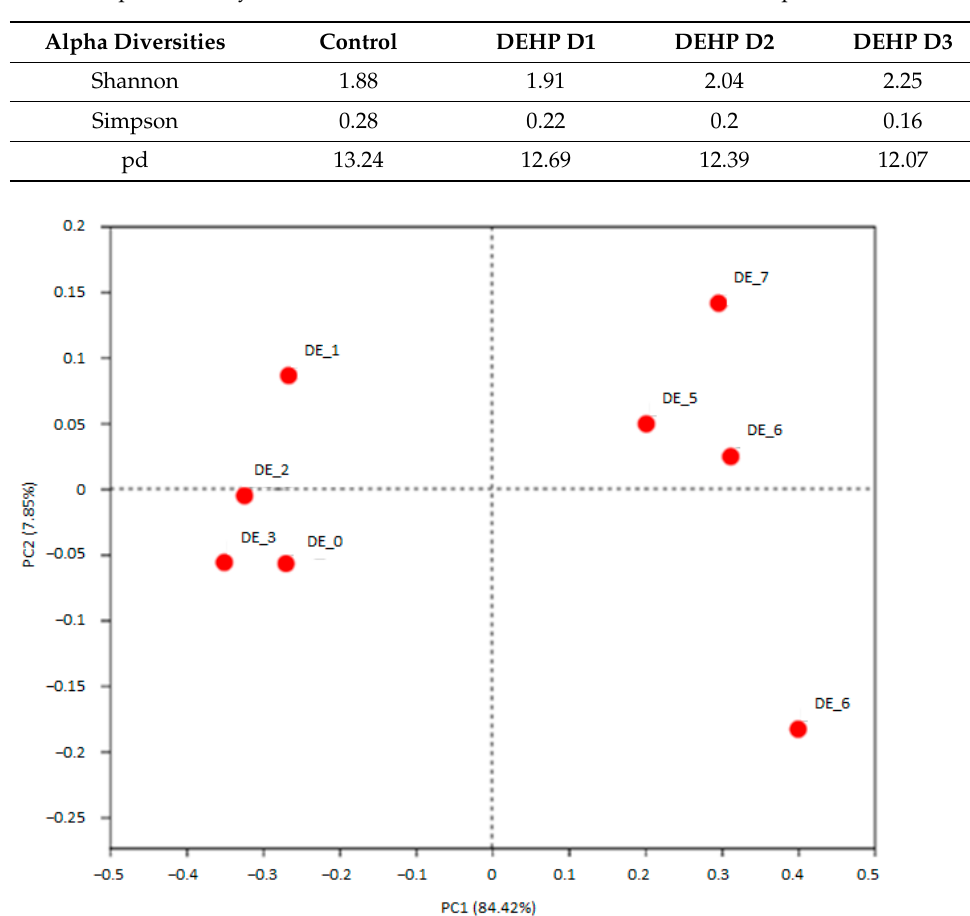
Table 1. Alpha diversity indices of resultant fermenter microbiota in DEHP experiment.